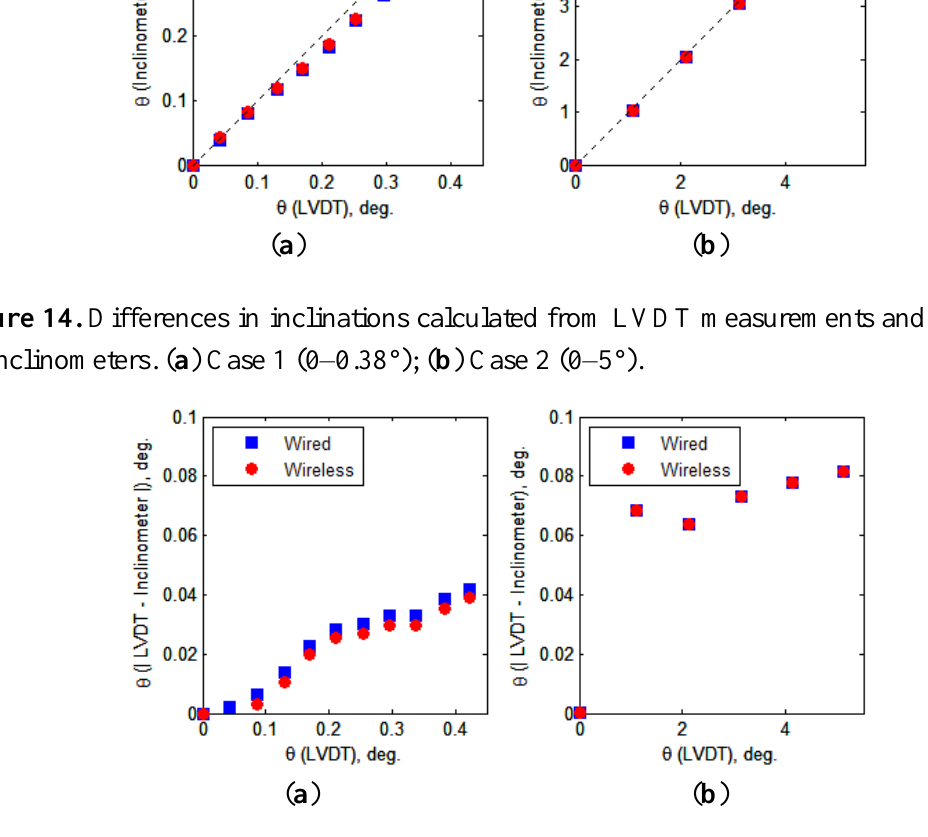
Figure 15. Differences in inclinations measured by wired and wireless inclinometers. ( a ) Case 1 (0–0.38°); ( b ) Case 2